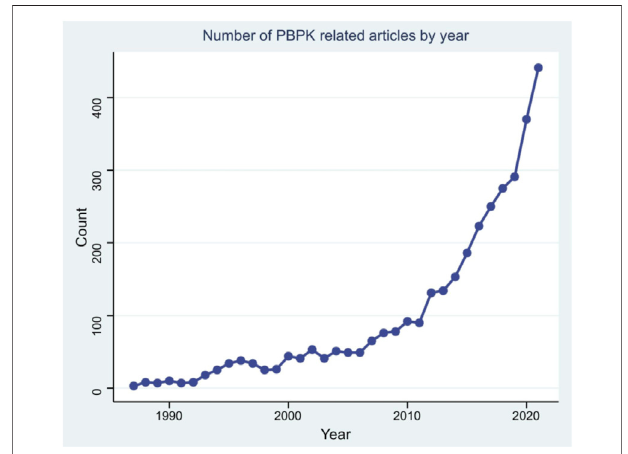
FIGURE 3 | Number of PBPK related articles by